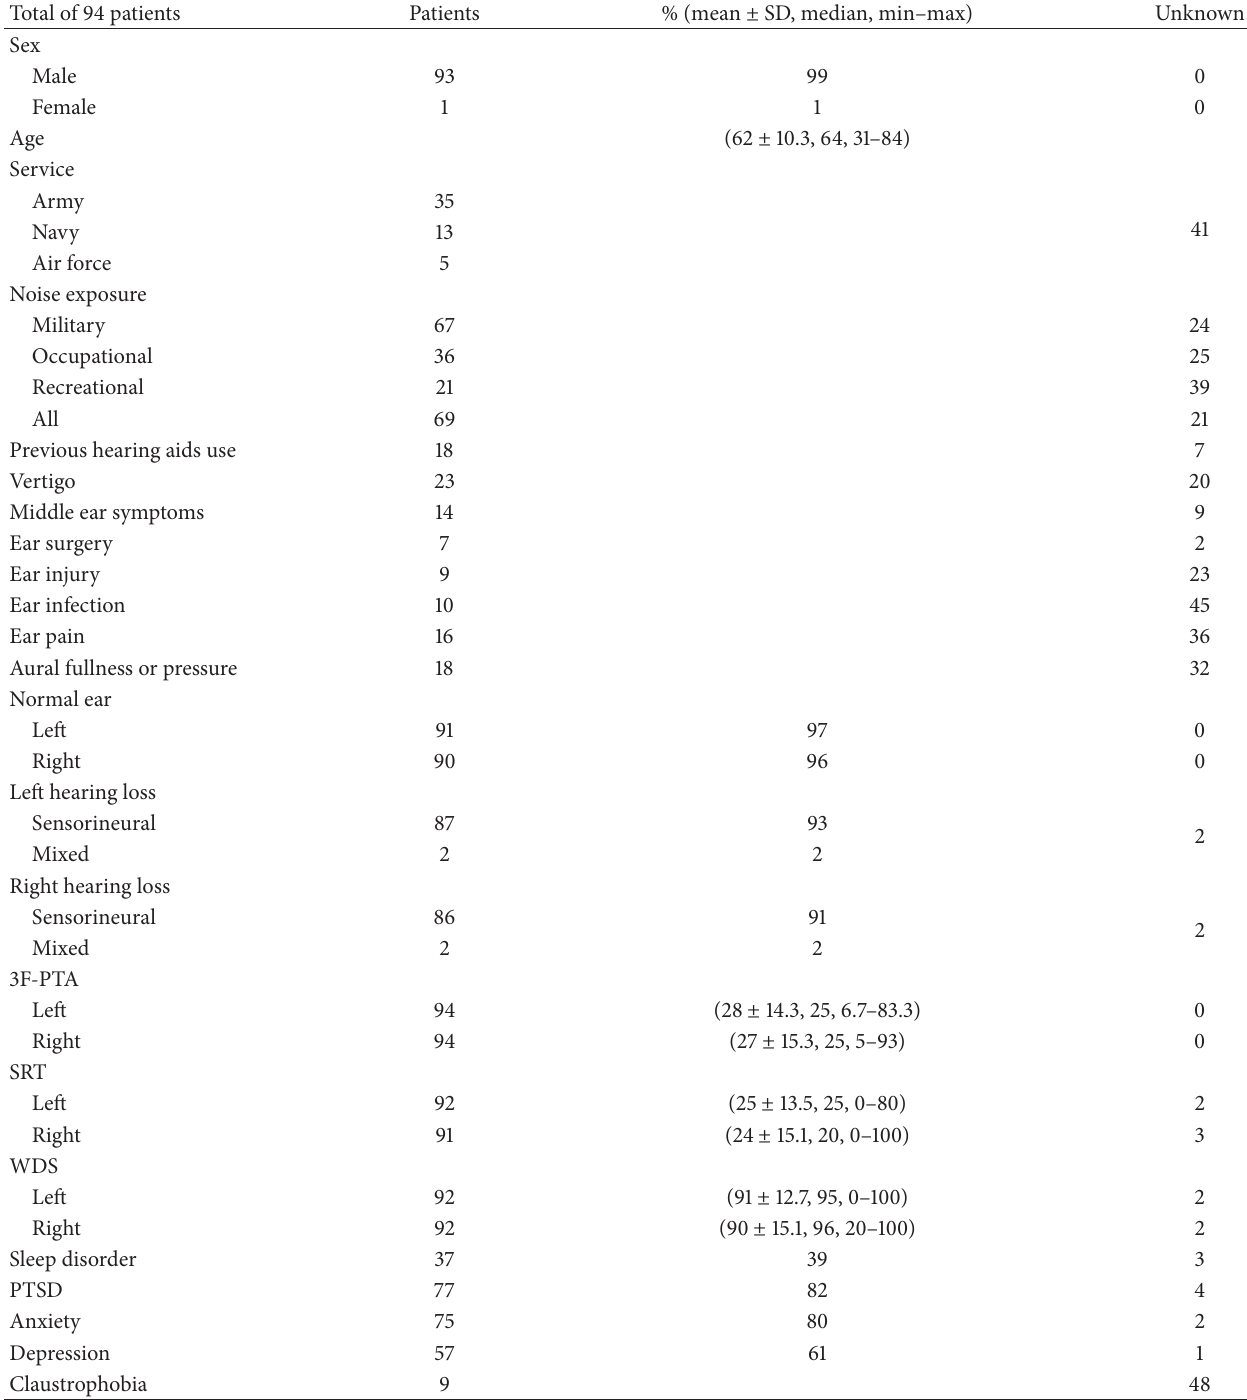
Table 1: Demographic, otologic, audiologic, and psychiatric profiles. SD: standard deviation, normal ear: tympanic membrane and external auditory canal, 3F-PTA: 3-frequency-pure-tone average (500, 1,000, and 2,000 Hz), SRT: speech reception threshold, WDS: word discrimination score, and PTSD: posttraumatic stress